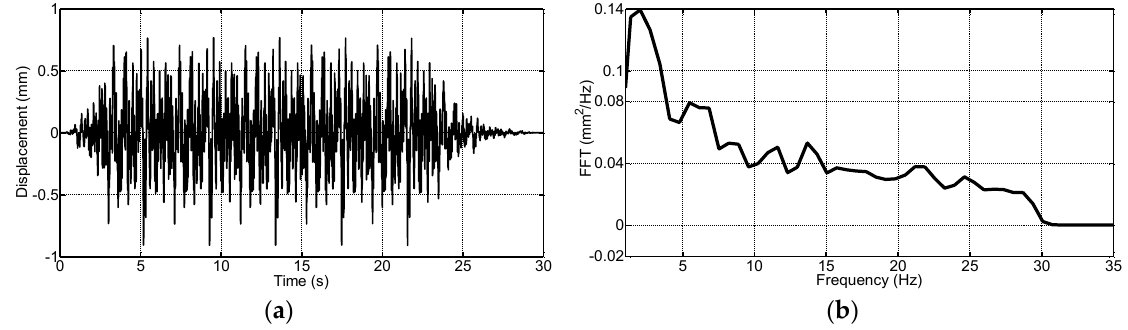
Figure 18. Sine signal synchronization control test results. ( a ) Without synchronization control; ( b ) synchronization control with standard sliding mode control (SMC); ( c ) Proposed sliding mode control based on adaptive reaching law (ASMC) synchronization control.